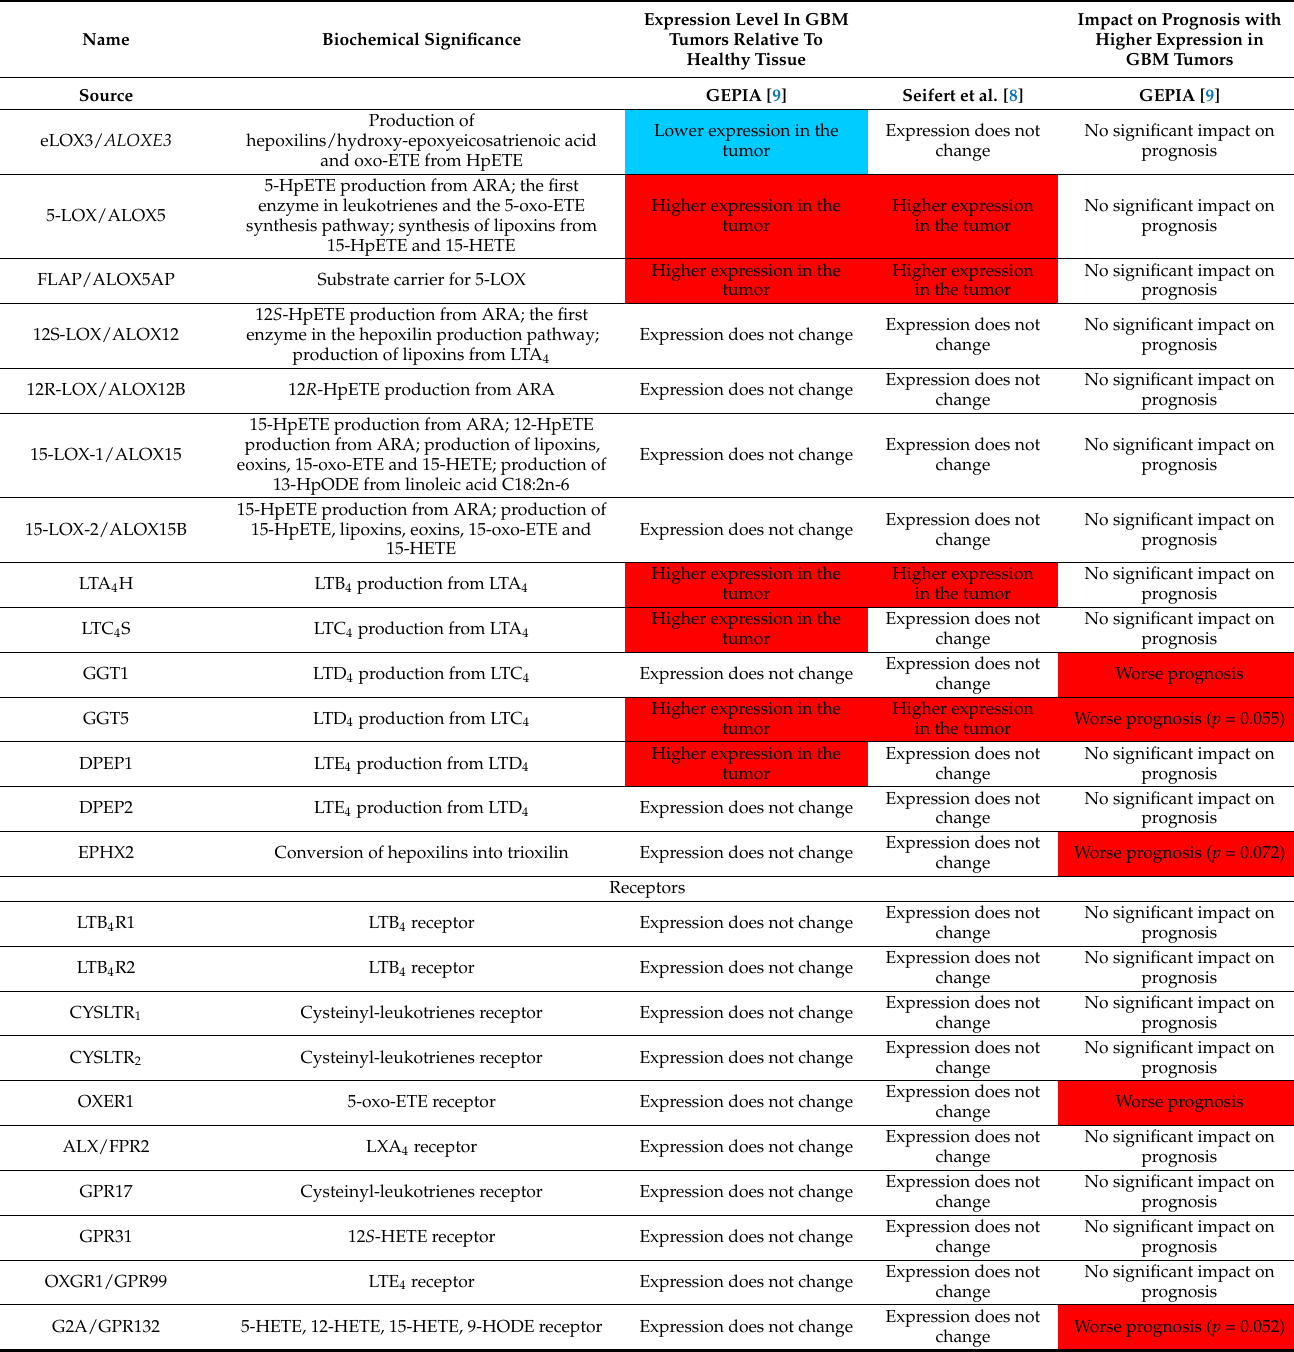
Table 7. Description of the various enzymes involved in the synthesis, action, and degradation of lipoxygenases along with their involvement in tumorigenesis in